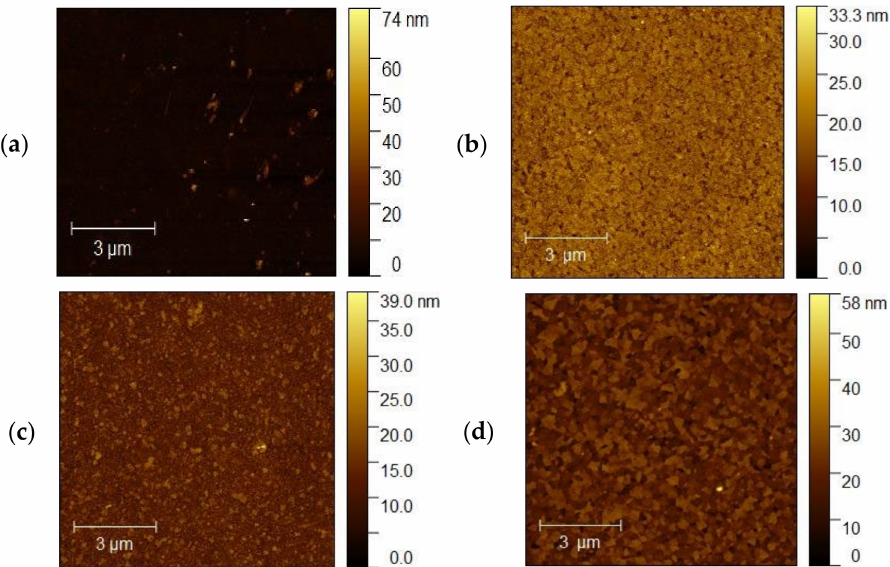
Figure 10. AFM images of the ( a ) ITO1, ( b ) ITO2, ( c ) ITO3, ( d ) ITO4 before Ag nanoparticle deposition.